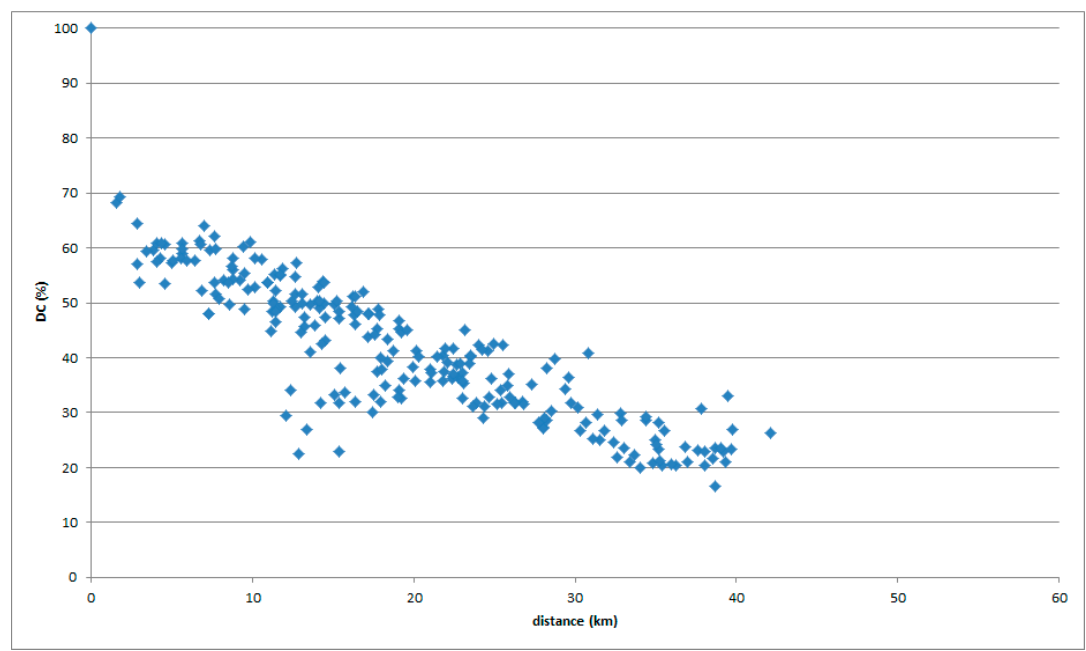
Figure 20. Kamiina-no Hogen data with a reference place in Minowa.